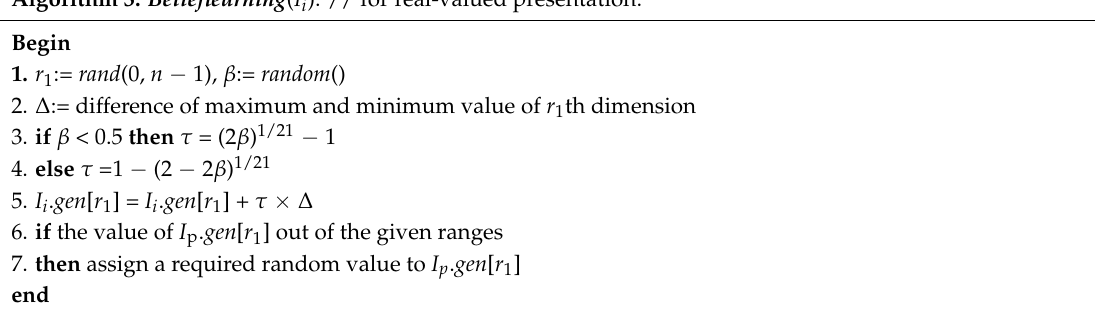
Algorithm 3. Belieflearning ( I i ). // for real-valued